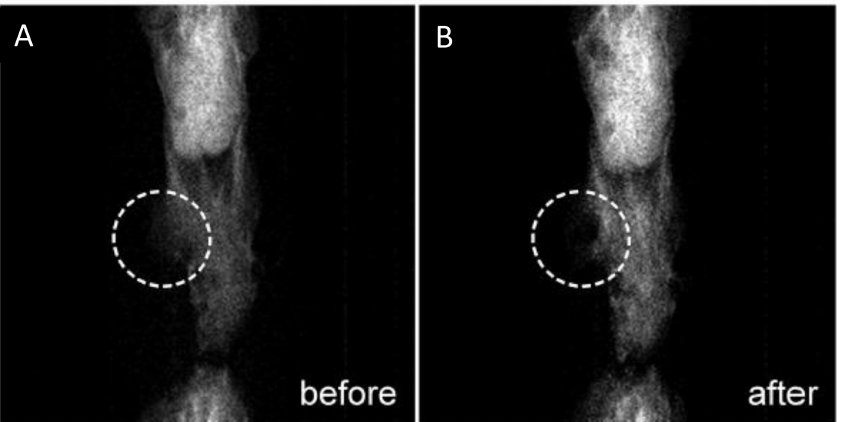
Figure 4. In vivo MR images of a mouse ( A ) before and ( B ) after injection of BPs@Au@Fe 3 O 4 nanocomposite. Figure adapted with permission from [62], Copyright 2017 WILEY-VCH Verlag GmbH & Co. KGaA, Weinheim.